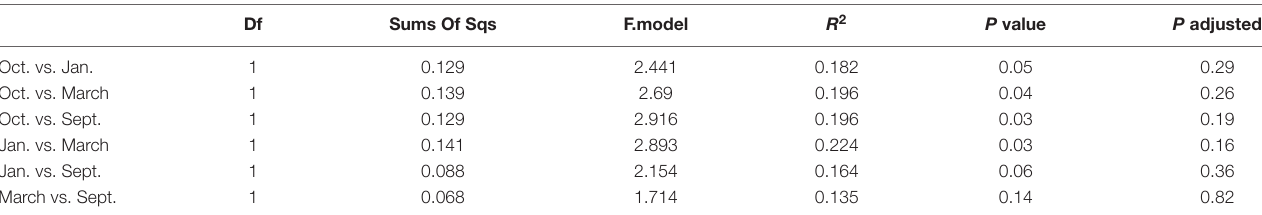
TABLE 2 | Pairwise-PERMANOVA results based on Bray-Curtis dissimilarity on Hellinger standardized densities of zooplankton community structure in relation to cruise.